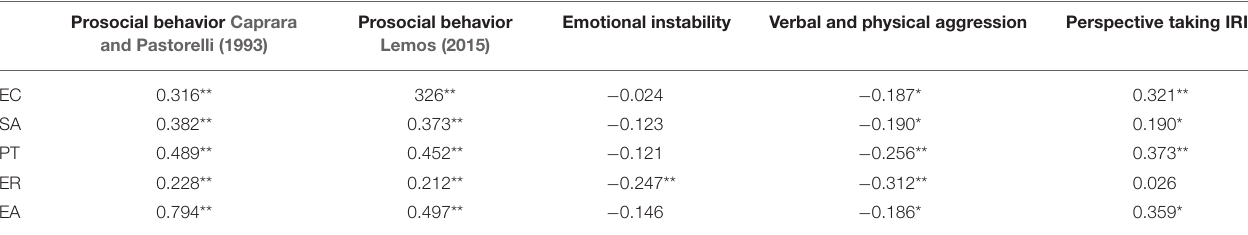
TABLE 3 | Correlations between emotional contagion, self-other awareness, perspective-taking, emotional regulation, and empathic action with prosocial behavior, emotional instability, aggression, and IRI perspective-taking. Prosocial behavior Caprara and Pastorelli